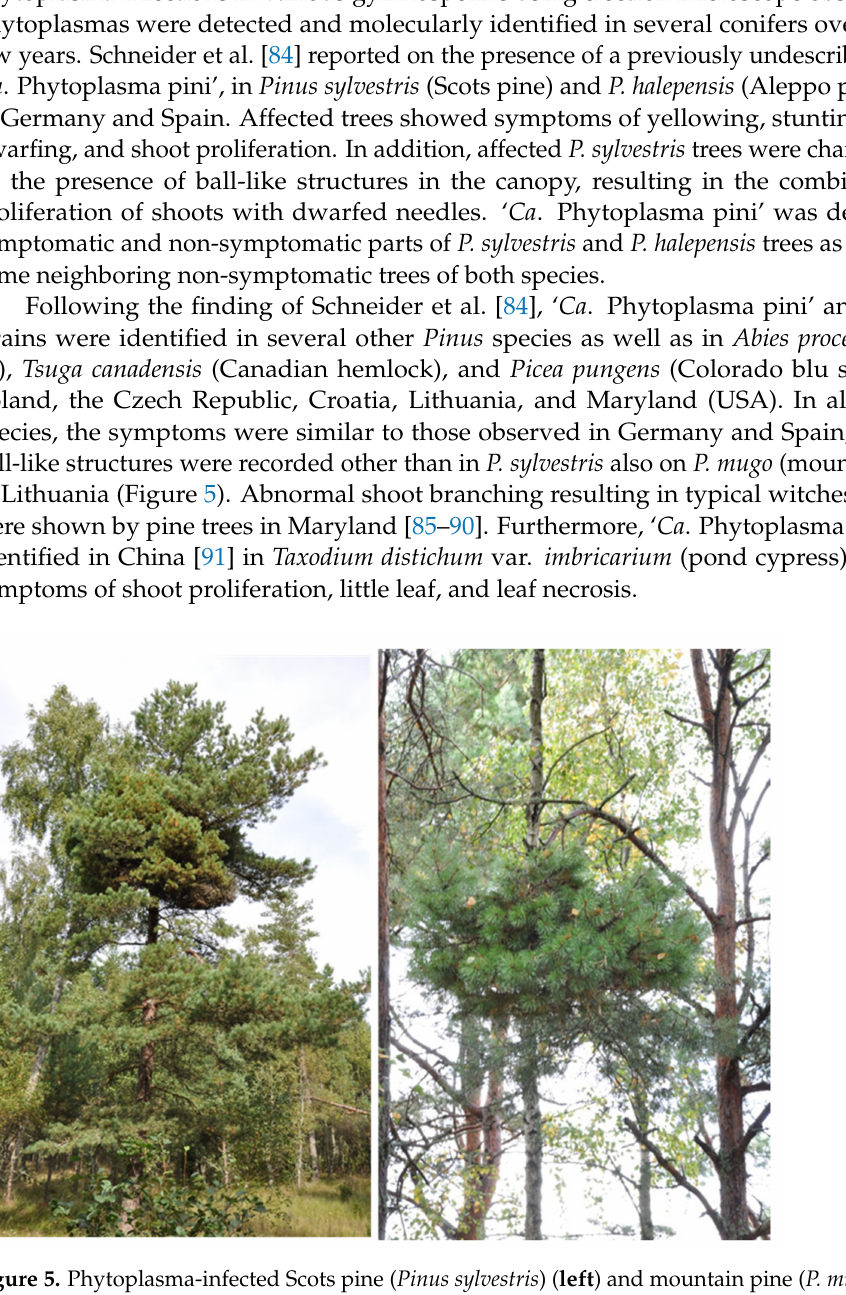
Figure 5. Phytoplasma-infected Scots pine ( Pinus sylvestris ) ( left ) and mountain pine ( P. mugo ) ( right ) trees showing ball-like